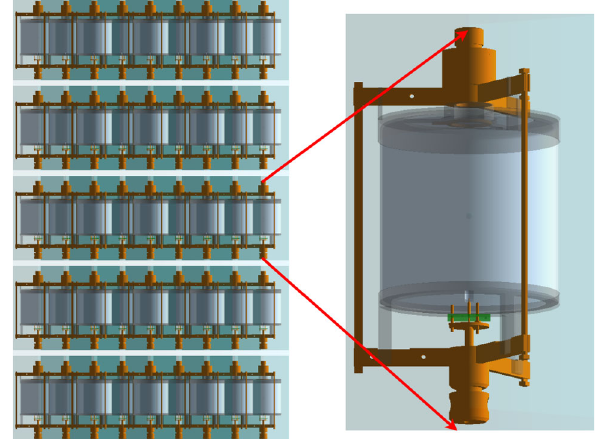
Fig. 3 Sketch of PPCGe detector array (left) and PPCGe detector unit (right) implemented in SAGE, together with its cupreous components, shown in orange. The PPCGe detector array is immersed in liquid nitro- gen in the simulation